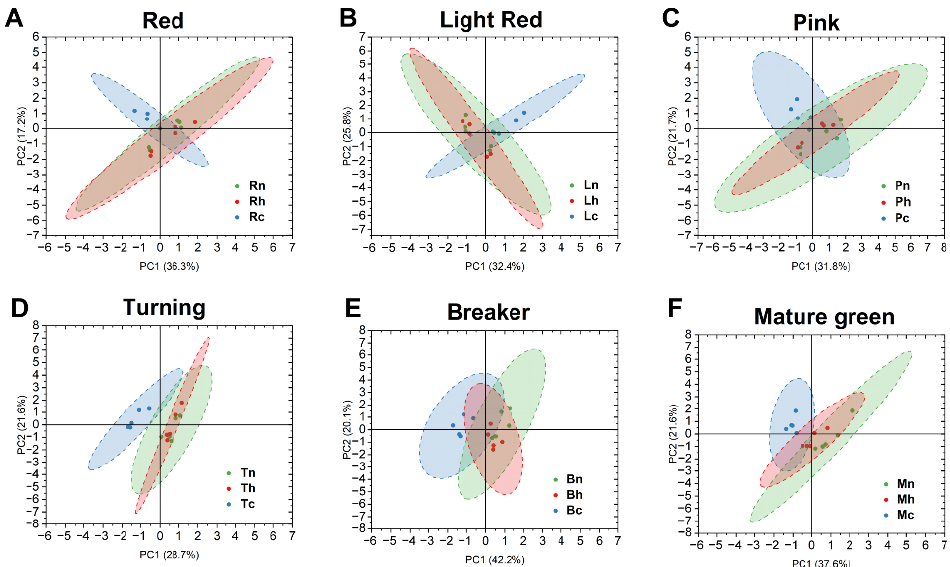
Figure 4. Principal component analysis (PCA) results based on all volatile compounds in “Tasti-Lee” tomatoes with different temperature treatments at six harvest maturities: ( A ) red, ( B ) light red, ( C ) pink, ( D ) turning, ( E ) breaker, and ( F ) mature green. Abbreviations represent combinations of harvest maturity (R—red; L—light red; P—pink; T—turning; B—breaker; and M—mature green) and temperature treatment (h—heating; c—chilling; n—non-treated control).